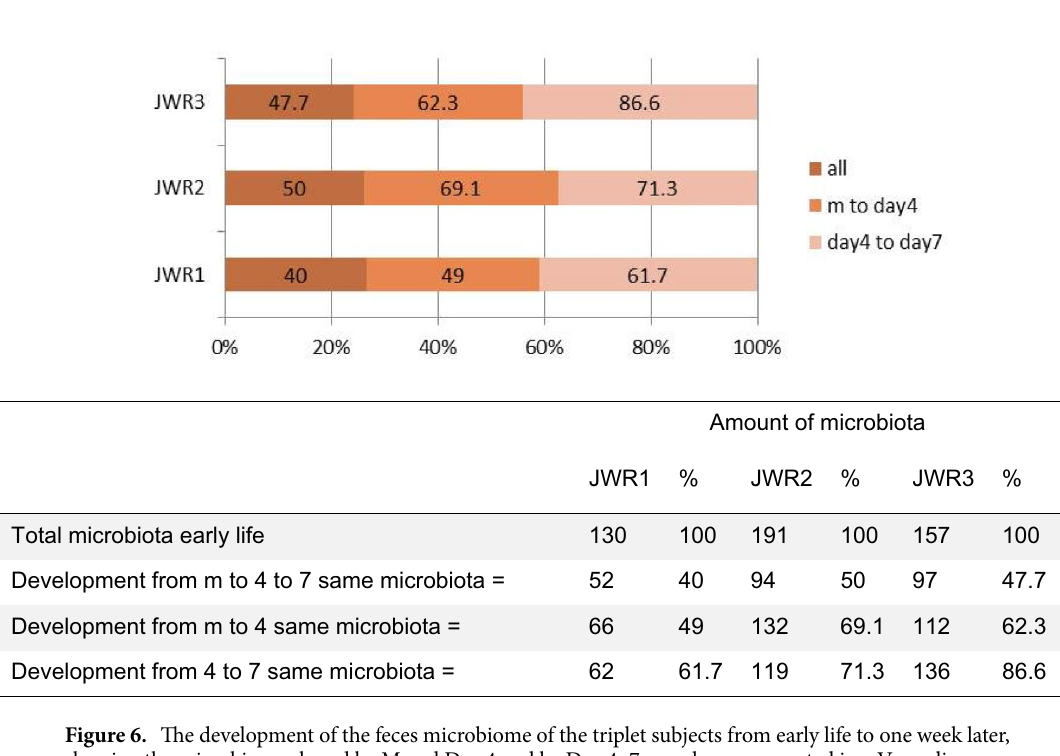
Figure 6. The development of the feces microbiome of the triplet subjects from early life to one week later, showing the microbiome shared by M and Day 4 and by Day 4–7 samples, as presented in a Venn diagram (Supplementary Fig. 14). The proportion (percentage) of the same microbiome diversity is summarized as a horizontal bar, and the matrix is underneath